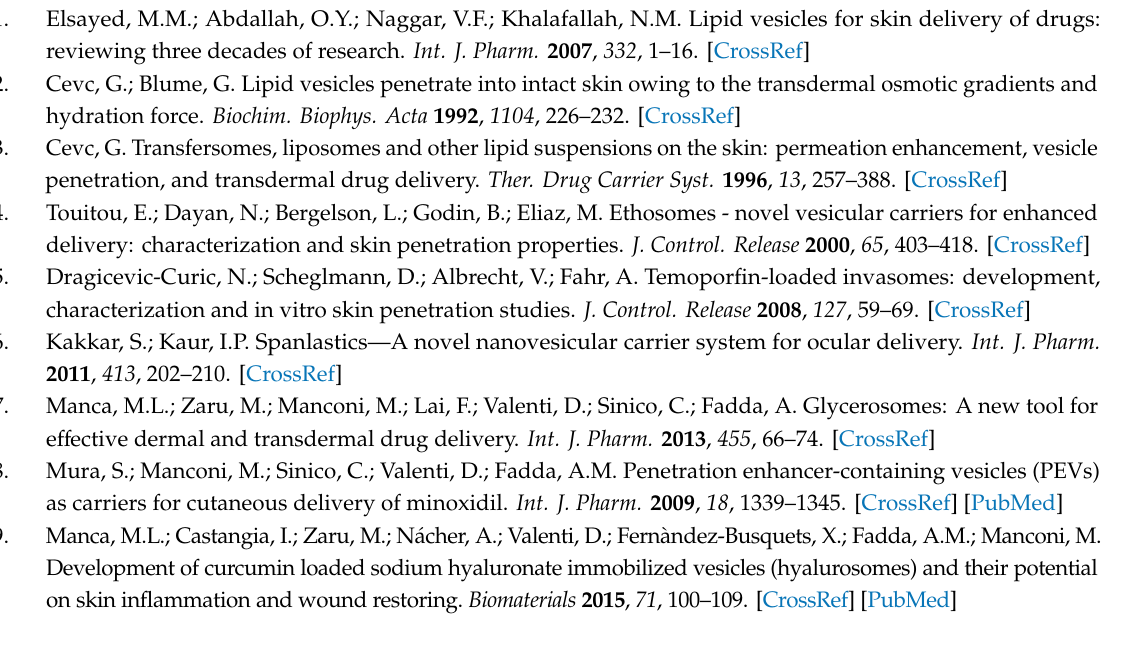
Supplementary Materials: “Stability of Deformable Nanovesicles to Begradation by Buccal Enzymes” is available online at: http: // www.mdpi.com / 1999-4923 / 11 / 10 / 539 / s1. Author Contributions: Data curation, Y.X.; Formal analysis, Y.X., Y.G. and Y.M.; Investigation, Y.X., Y.G. and